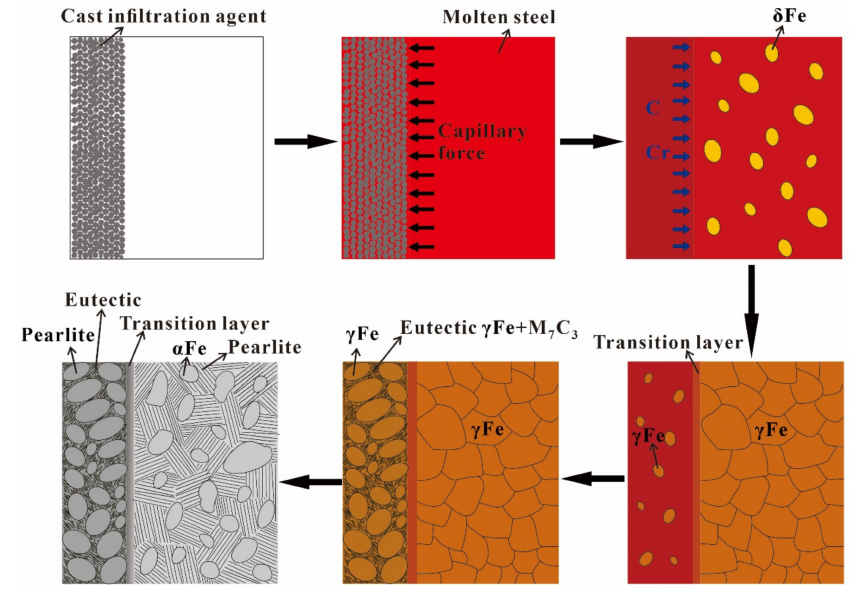
Figure 9. Schematic diagram of the microstructure evolution of the surface composite material during the cast infiltration process.